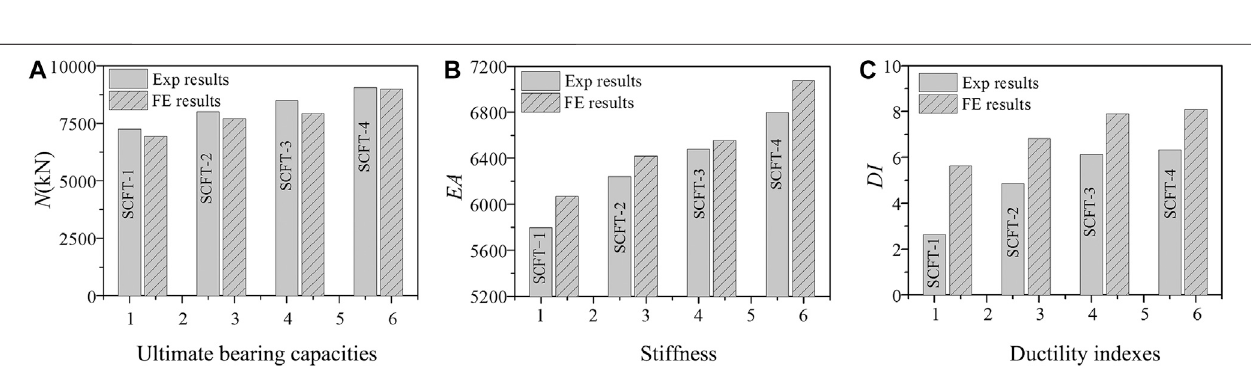
FIGURE 6 | Comparison of ultimate bearing capacities, stiffness and ductility indexes for all